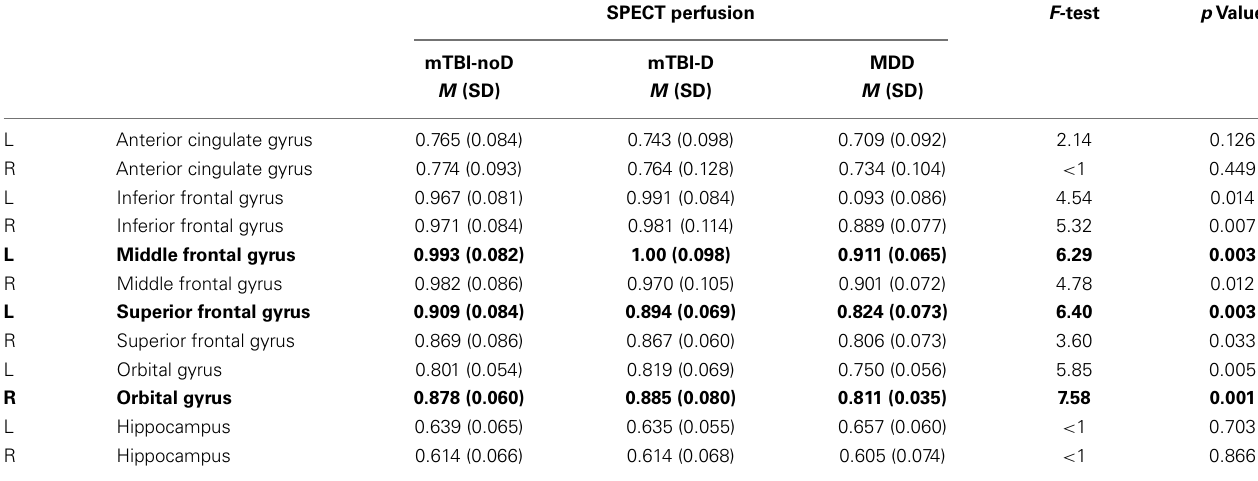
Table 2 | Mean SPECT perfusion in regions of interest inTBI patients with or without depressive symptoms and patients with MDD